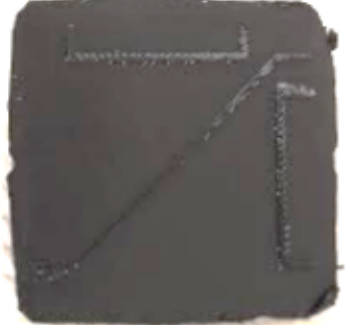
Figure 5. Manufactured 2-layer MR elastomer with